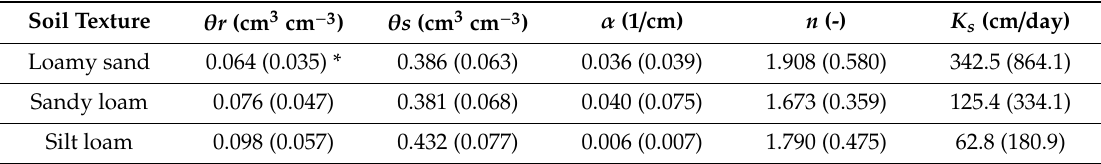
Table 2. Average values of soil hydraulic parameters for the van Genuchten–Mualem model generated for di ff erent soil textural